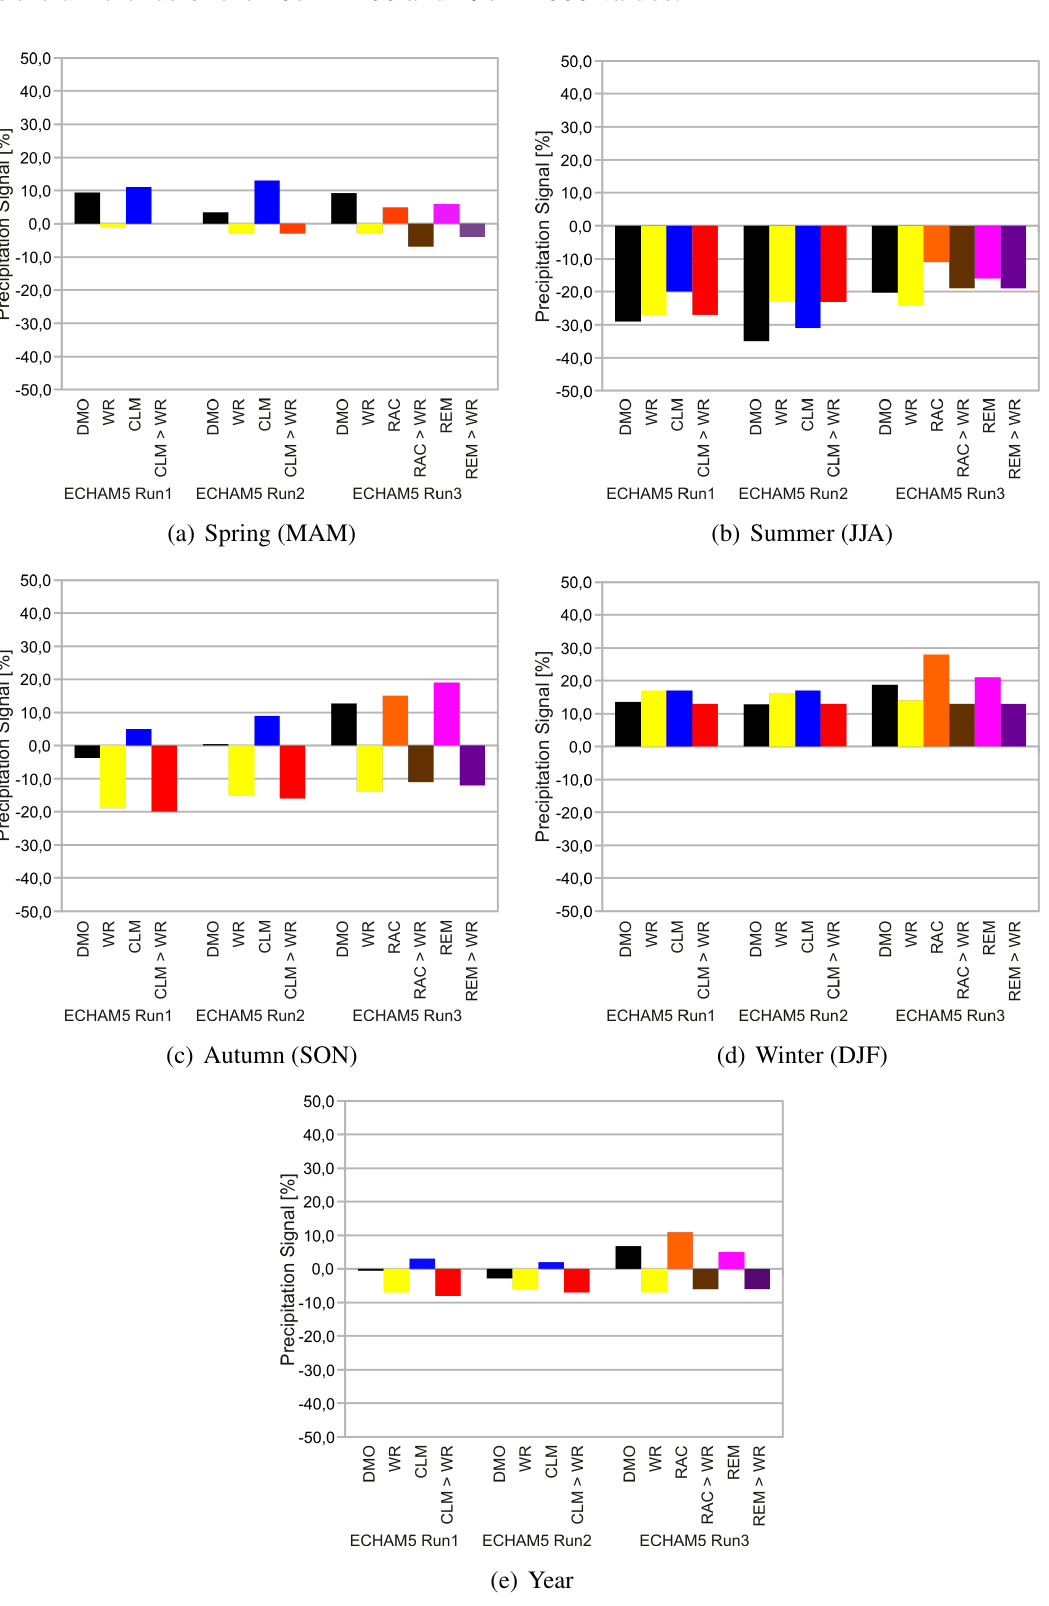
Figure 6. Comparison of the climate signals of precipitation (percentual change), computed as the difference of the 2071–2100 and 1971–2000